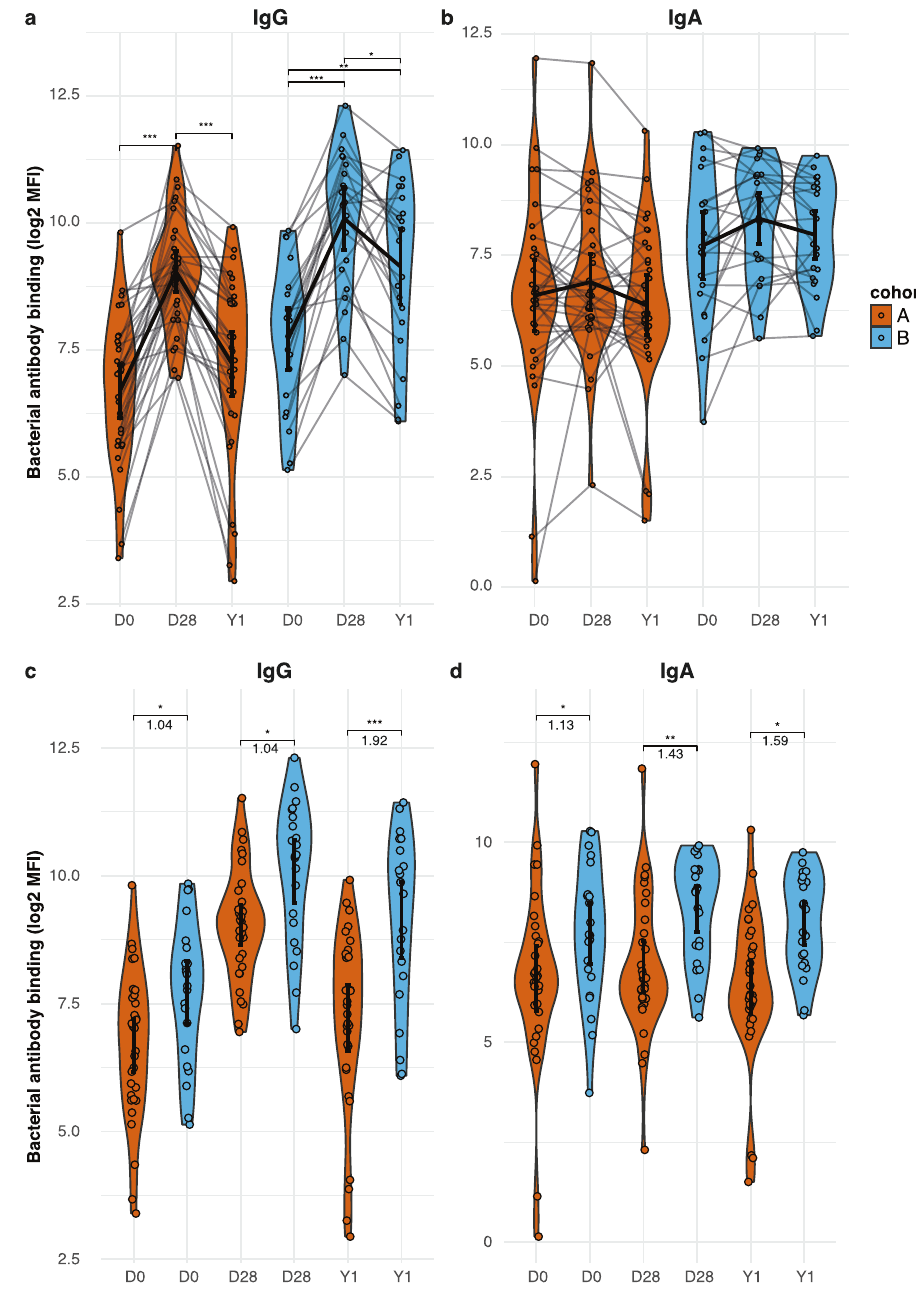
Fig. 4 | Effect of vaccination on mucosal antibody binding to B. pertussis . MLF wasobtainedfromparticipantsatbaseline(D0)and28days(D28)andoneyear(Y1) after a dose of Tdap-IPV. Bp_wt was incubated with heat-inactivated MLF and antibodybinding to bacteriawassubsequently measured by fl ow cytometry. Log2- transformed mean fl uorescence intensity (MFI) of IgG ( a ) and IgA ( b ) binding to Bp_wt overtimepercohort,andcross-cohortcomparisonpertimepointforIgG( c ) andIgA( d )bindingto Bp_wt .CohortAandcohortBareindicatedbycolor.Dataare N =32 individuals for cohort A and N =22 individuals for cohort B. Sample means with95%con fi